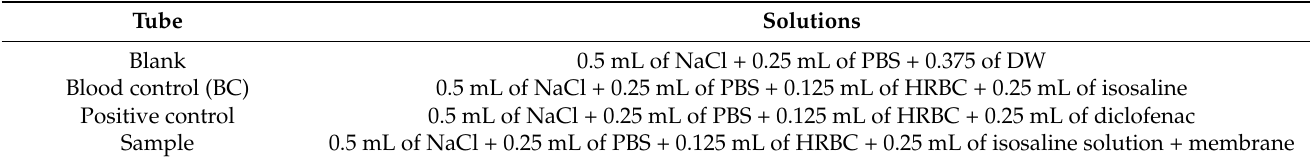
Table 2. Reaction tubes for in vitro anti-inflammatory